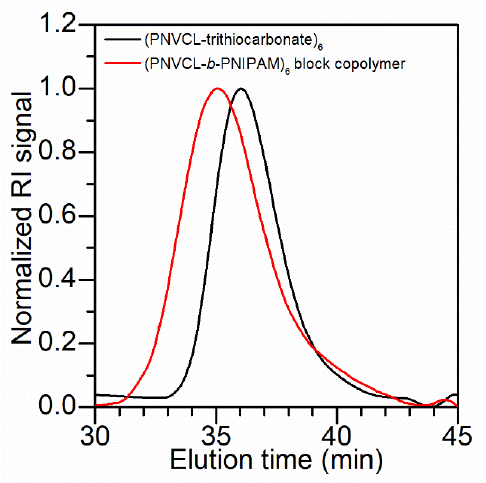
Figure 9. GPC traces in THF for the (PNVCL-trithiocarbonate) 6 star polymers ( M n GPC = 46,120 g/mol, Ð = 1.12) and the (PNVCL- b -PNIPAM) 6 star block copolymers ( M n GPC = 47,320 g/mol, Ð = 1.27).